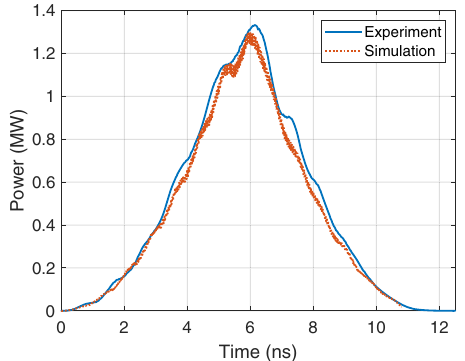
FIG. 19. Rf Pulse of a eight bunch train with total charge of 12 nC, along with accompanying PIC simulation